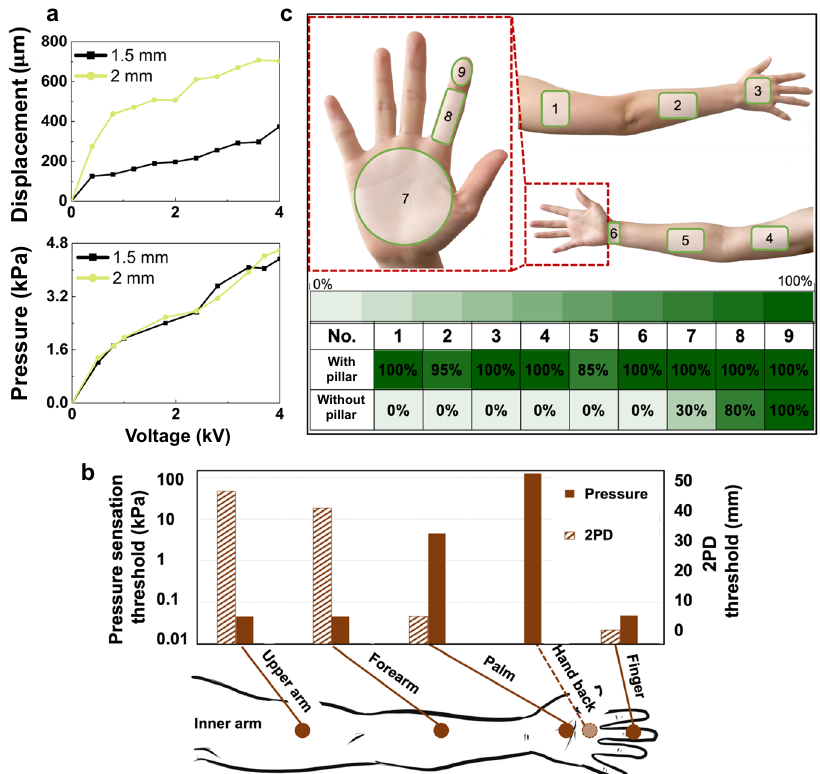
Fig. 5 Comparisons of actuators with different opening diameters and skin ’ s tactile sensation thresholds. a Measured out-of-plane displacement and output pressure for actuators with different opening diameters. b Pressure sensation thresholds and two-point discrimination thresholds at different skin locations (Data from refs. 7 – 11 , no data were found for the 2PD threshold at the hand back). c Top: skin locations chosen for the tactile perception user study. Bottom: identi fi cation rate of the tactile perception user study when the actuators with or without pillar were attached to the skin surface to generate